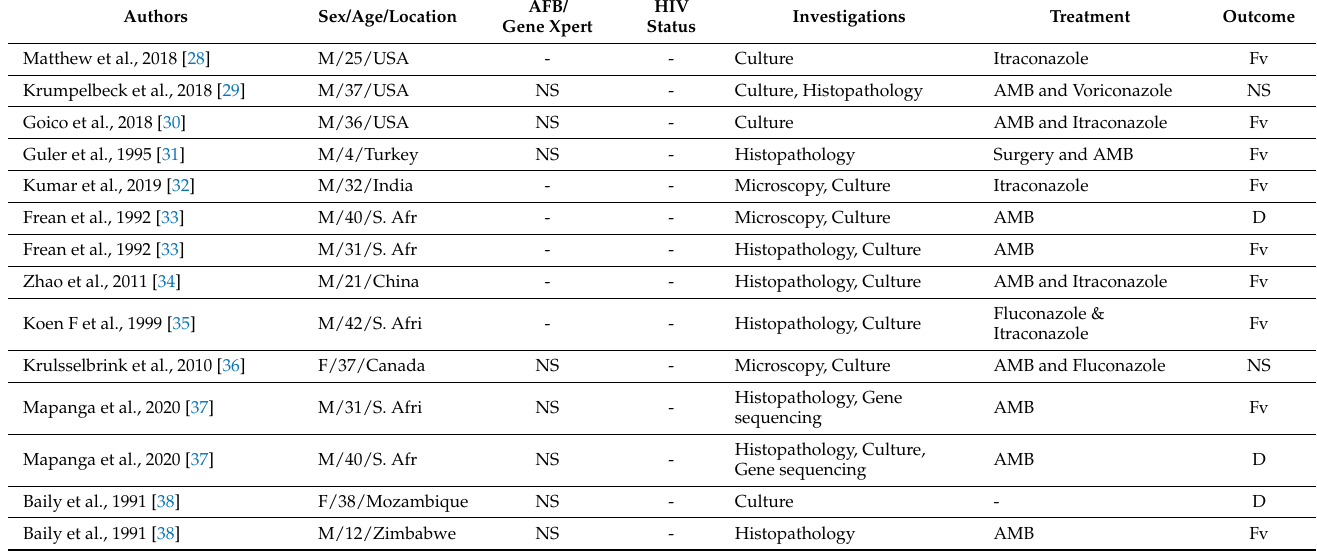
Table 4. Cases of blastomycosis misdiagnosed as TB.